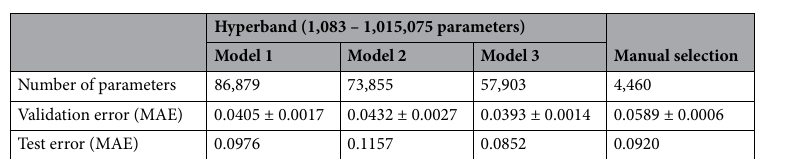
Table 1. K-fold cross validation results (MAE) of the top 3 performing model architectures selected by the Hyperband hyperparameter optimization algorithm compared with the model with manually selected